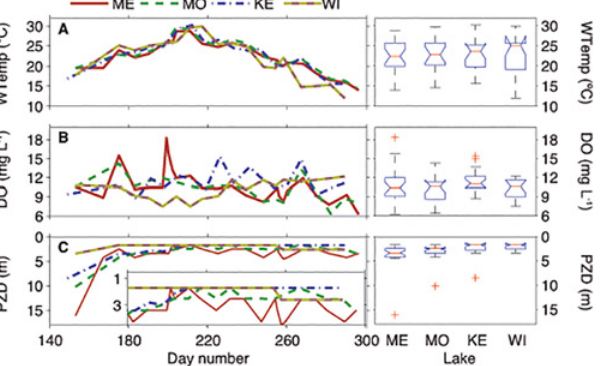
Fig 2. Time-series comparison of water temperature (WTemp), dissolved oxygen (DO), and photic zone depth (PZD), as well as boxplot results of one-way analysis of variance (ANOVA) of variables between the lakes. Lakes are in order from largest to smallest; left to right: ME = Mendota, MO = Monona, KE = Kegonsa, and WI = Wingra. PZD inset represents only days 180 –